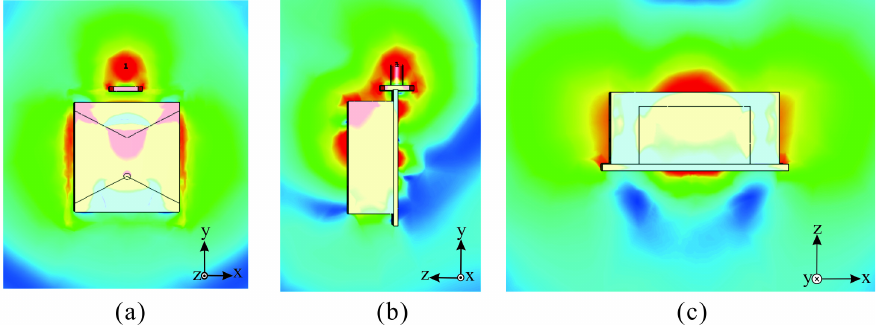
Figure 9. The simulated electric field distribution of the proposed antenna: ( a ) xy, ( b ) yz, and ( c ) xz